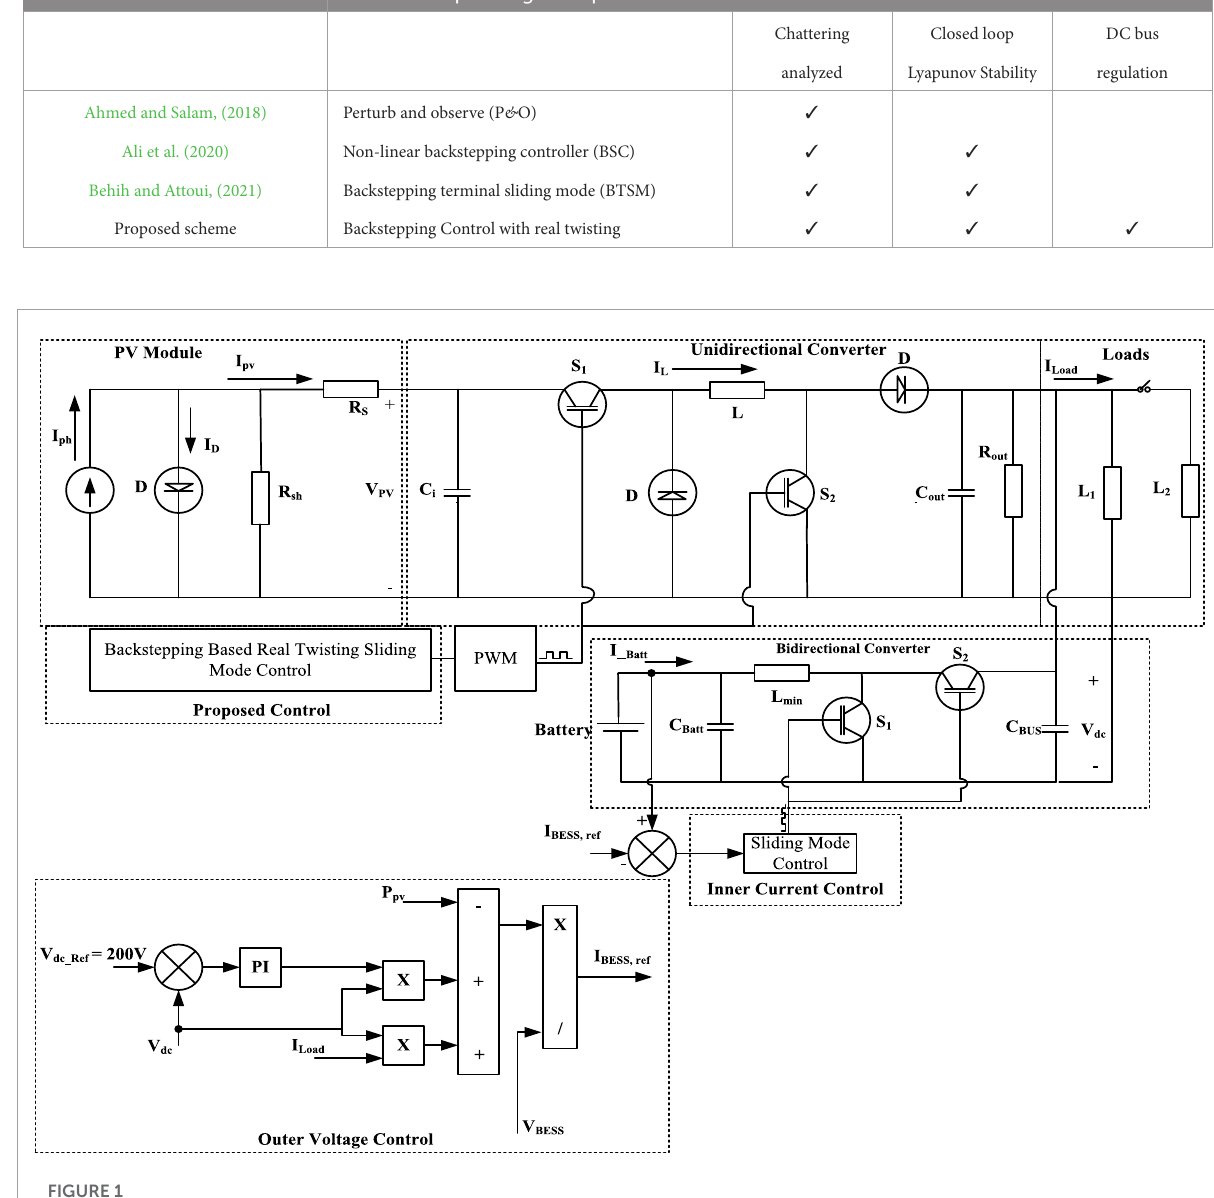
FIGURE 1 Photovoltaic battery connected system under consideration.